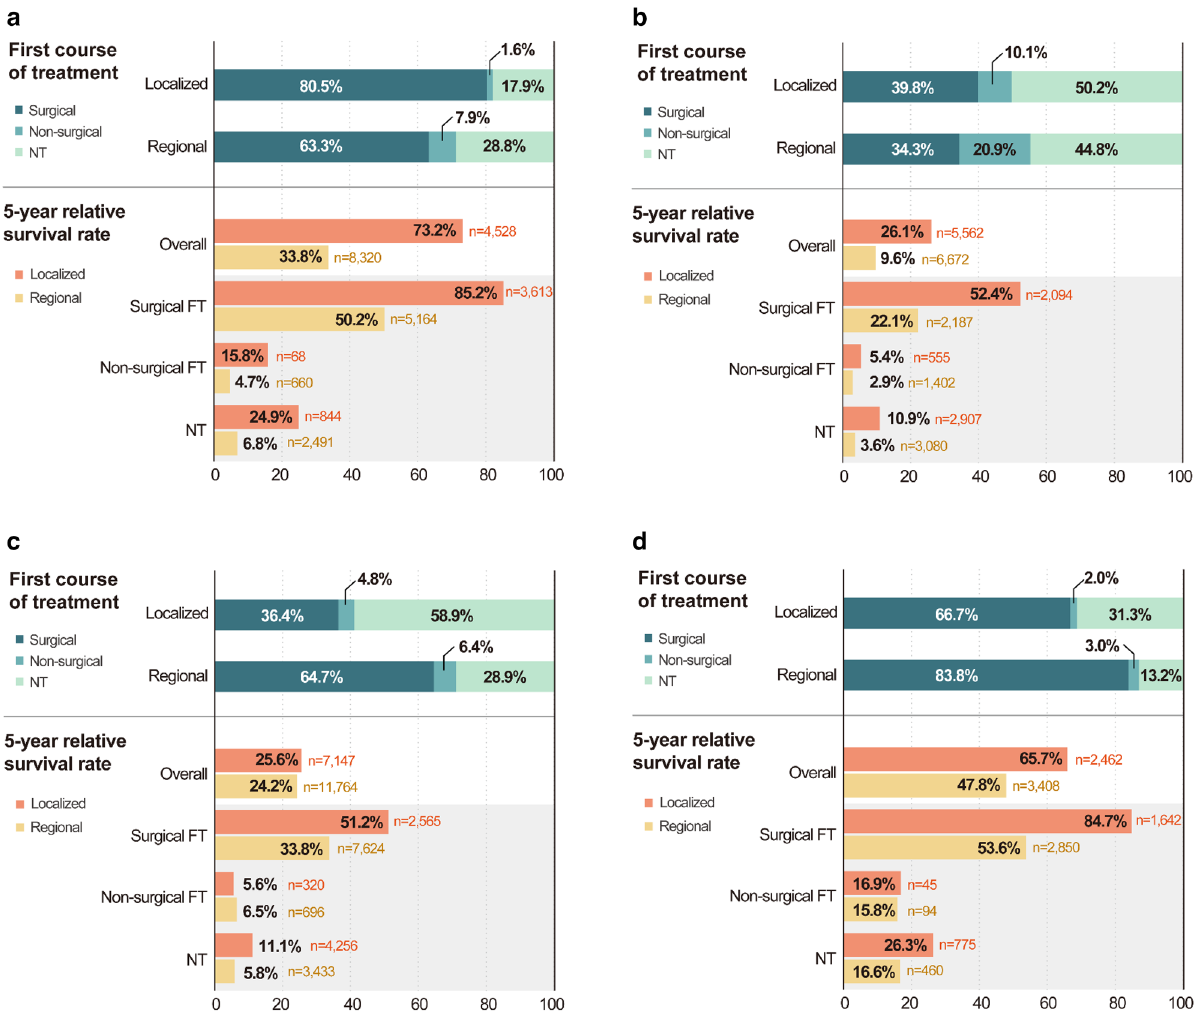
Figure 4. Treatment pattern and 5-year relative survival rate of localized and regional SEER stage biliary tract cancer according to tumor location. * NT no active anti-cancer treatment, FT first course of treatment. ( a ) Gallbladder cancer. ( b ) Intrahepatic bile duct cancer. ( c ) Extrahepatic bile duct cancer. ( d ) Ampulla of Vater